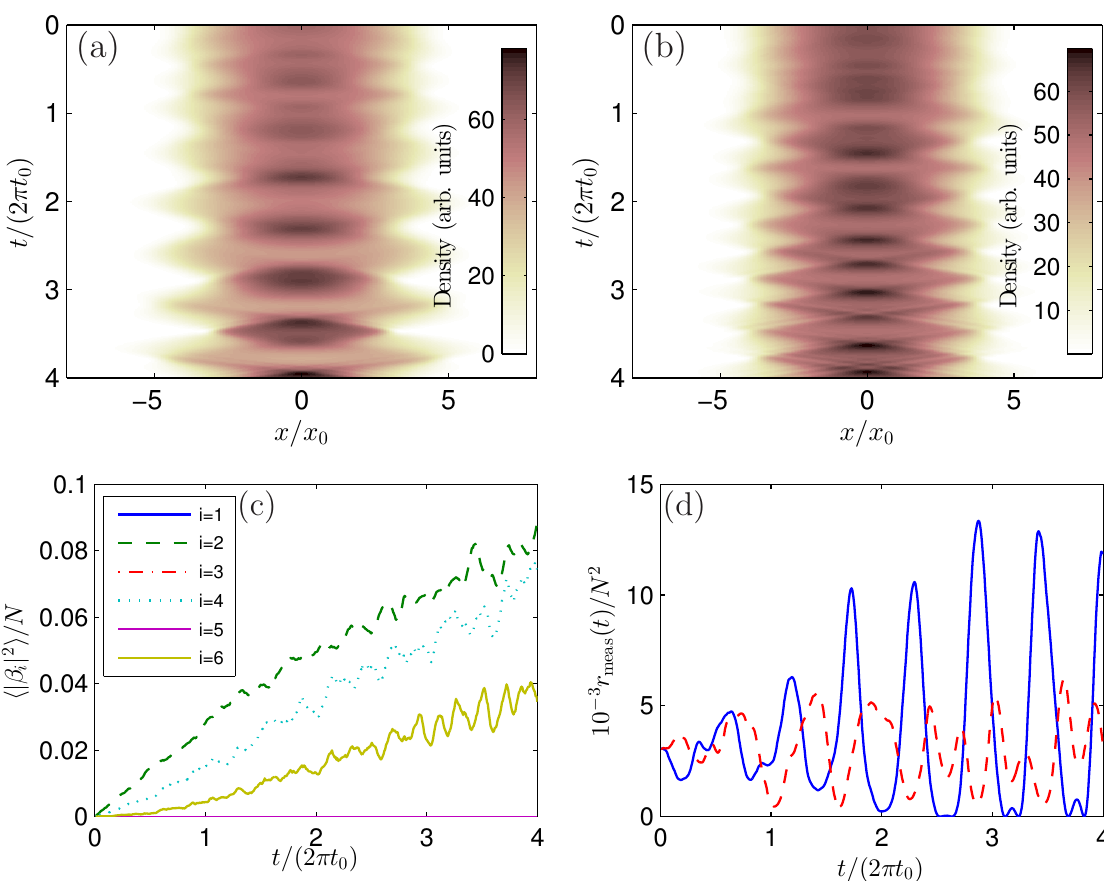
Figure 7. Response of the condensate to measurement backaction when the cavity mode coupling g ( x ) is tailored to give a maximum overlap with the breathing mode, centering the trap potential on a cavity antinode such that g ( x ) = g cos( kx ) . ( a , b ) Two single realizations 0 of the condensate stochastic field density | ψ ( x, t ) | 2 . ( c ) Bogoliubov mode populations, averaged over 400 realizations. Subfigure reproduced from [15]. ( d ) Measurement rate r ( t ) corresponding to the density evolutions shown in ( a ) (blue, solid) and ( b ) meas (red,